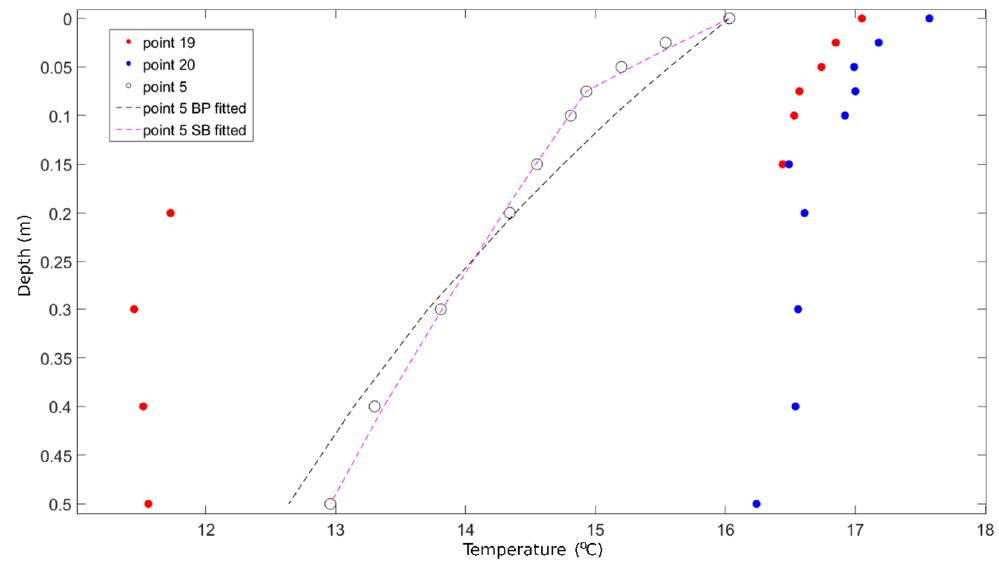
Figure 6. The temperature-depth profiles for points 5, 19 and 20. An example of reasonably fitted data is point 5 (empty black dots), fitted with both BP (black dashed line) and SB (magenta dashed line). An anomalous change in the temperature can be observed for point 19 (red dots) from depth 0.15 m to depth 0.2 m. The temperature at point 20 (blue dots) remained above 16 °C along the entire 0.5 m profile.